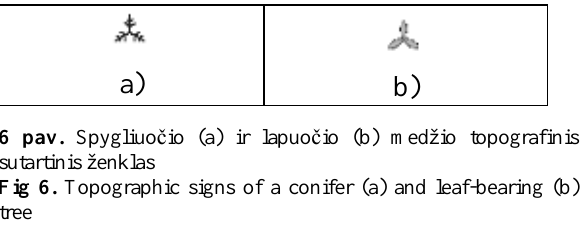
Fig 6. Topographic signs of a conifer (a) and leaf-bearing (b) tree 7. Atramos taško aiškumas . Sutartinis ženklas turi tiksliai (žem ė lapio ar plano tikslumu) žym ė ti reali ų objekt ų pad ė t į , tod ė l turi tur ė ti fiksuot ą tašk ą . Ypa č tai